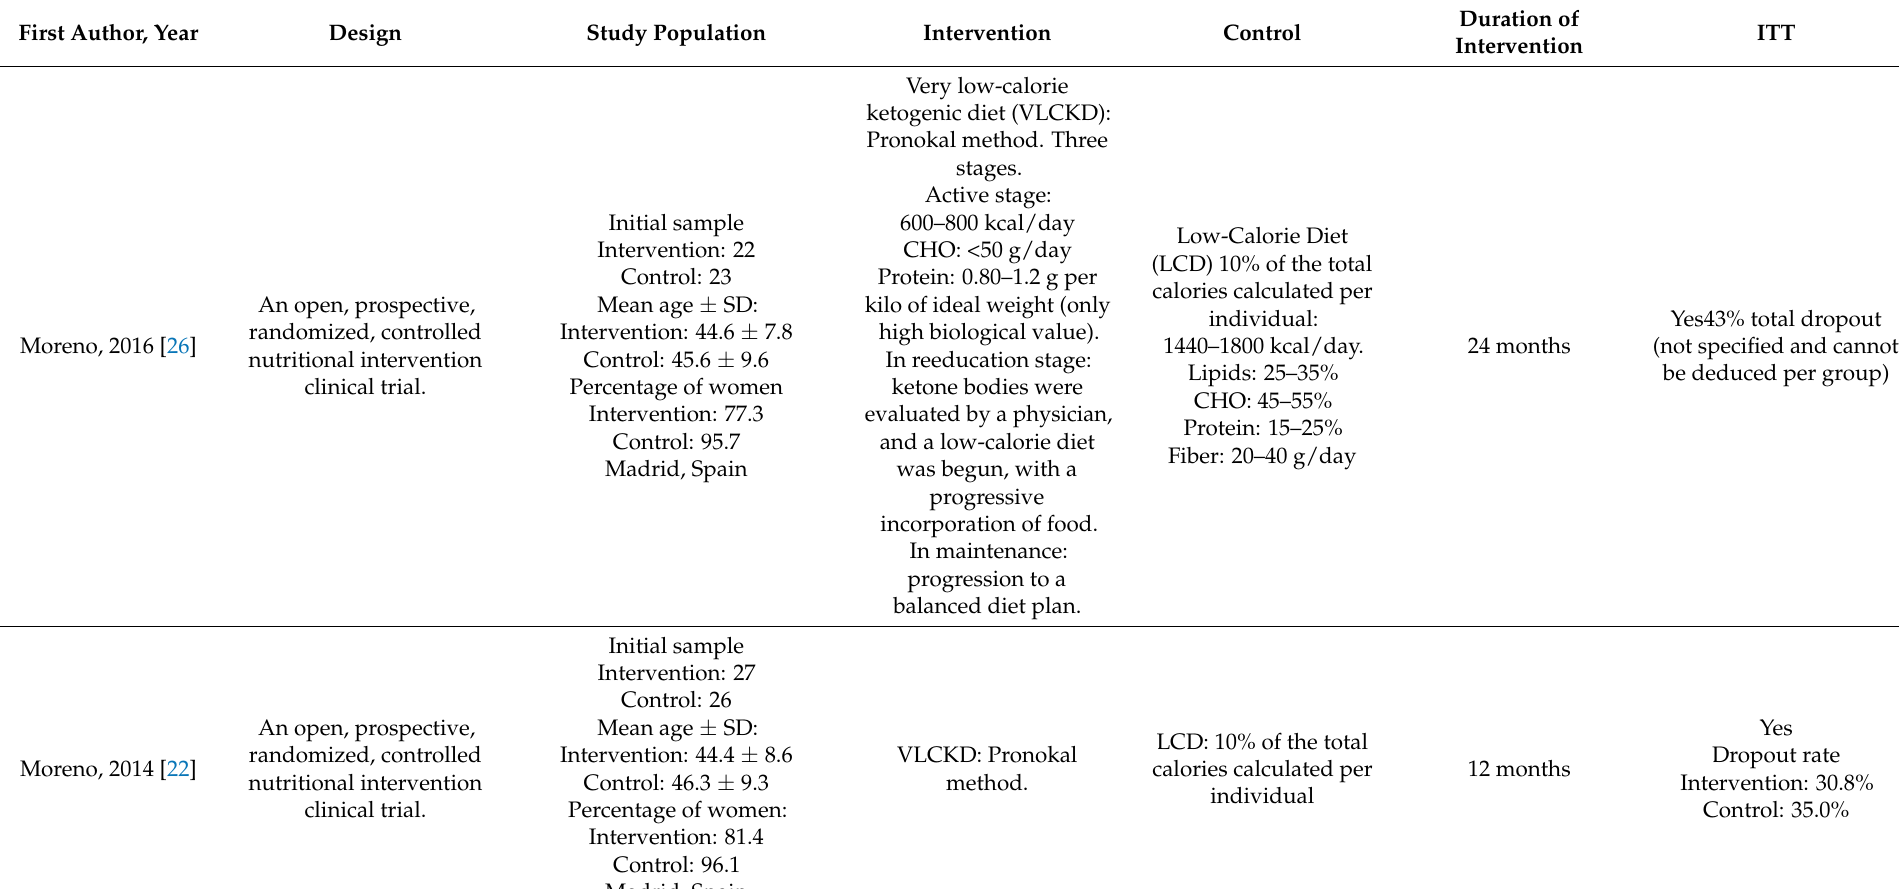
Table 1. Characteristics of studies